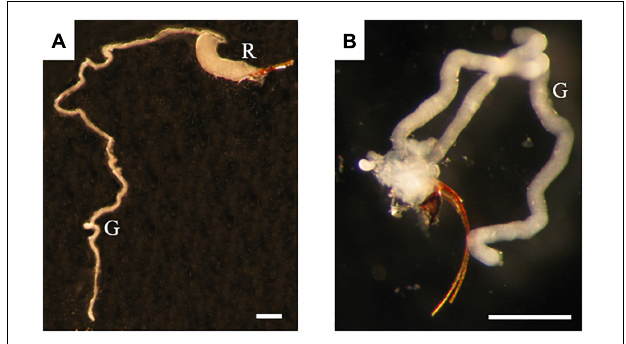
FIGURE 1 | Venom apparatus of B. pallida (A) and D. rosae (B) females. G, venom gland; R, venom reservoir. Scale bars = 0,6